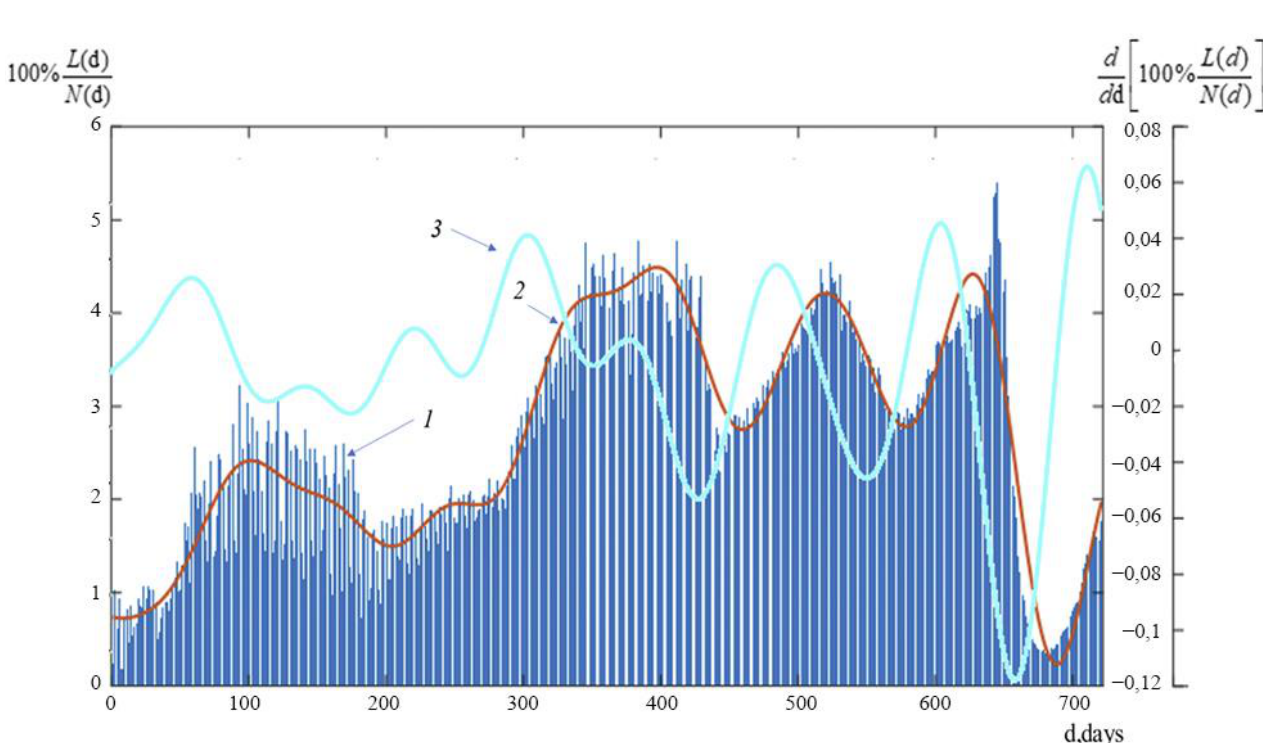
Figure 6. The relative daily deaths in Russia. 1—the real dates of relative death from COVID-19 in Russia in %; 2—the average dates of relative death from COVID-19 in Russia in %; 3—the velocity of the average dates of relative death from COVID-19 in Russia in %.